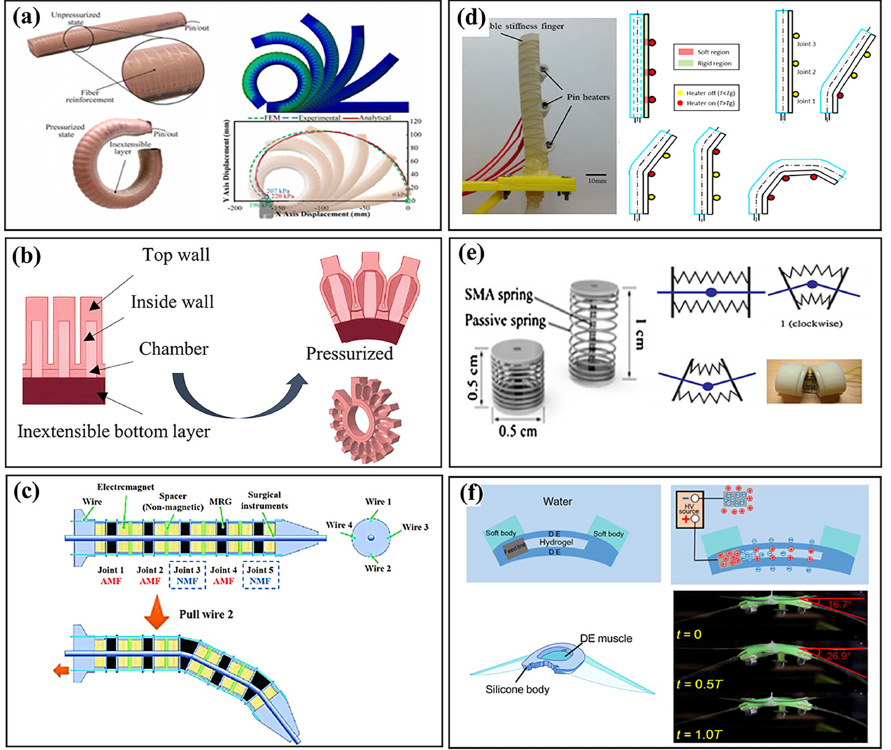
Figure 9. ( a ) The bending motion and finite element analysis of a fiber-reinforced soft actuator [75]. ( b ) Pneumatic network structure and bending posture under pressure [ ? ]. ( c ) Bending motion of the variable stiffness multi-joint actuator [82]. ( d ) Actuator prototype with bending status of each joint [83]. ( e ) Single spring structure and bending posture combining two spring units [84]. ( f ) The internal structure and actuation principle of a bending actuator